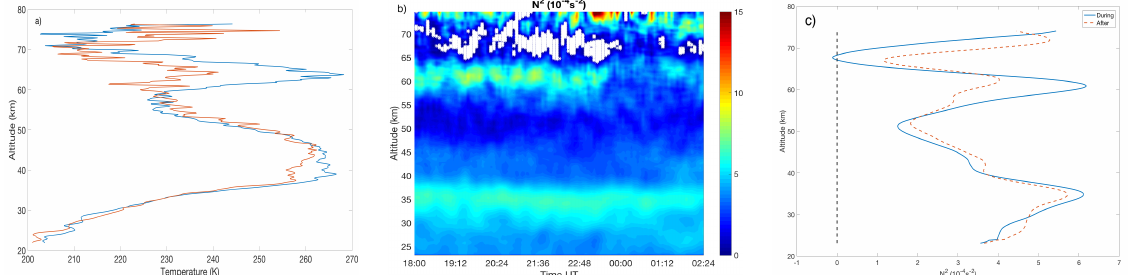
Figure 9. ( a ) Rayleigh lidar temperature profiles. The blue curve represents the average temperature for each altitude before midnight, and the red curve is the average temperature after midnight [20]. ( b ) Square Brunt–Väisälä frequency profile during the night of 12 December 2017 at the Haute- Provence observatory. White dots show negative values. ( c ) Mean square Brunt–Väisälä frequency profile before midnight in blue and after midnight in red. The 0 value is indicated by the dotted black vertical line.